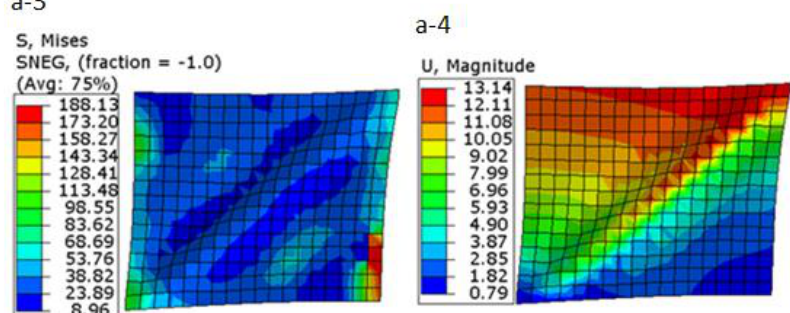
Figure 9. Von Mises stress and displacement for concrete part (a - 3) stress and (a-4) displacement.